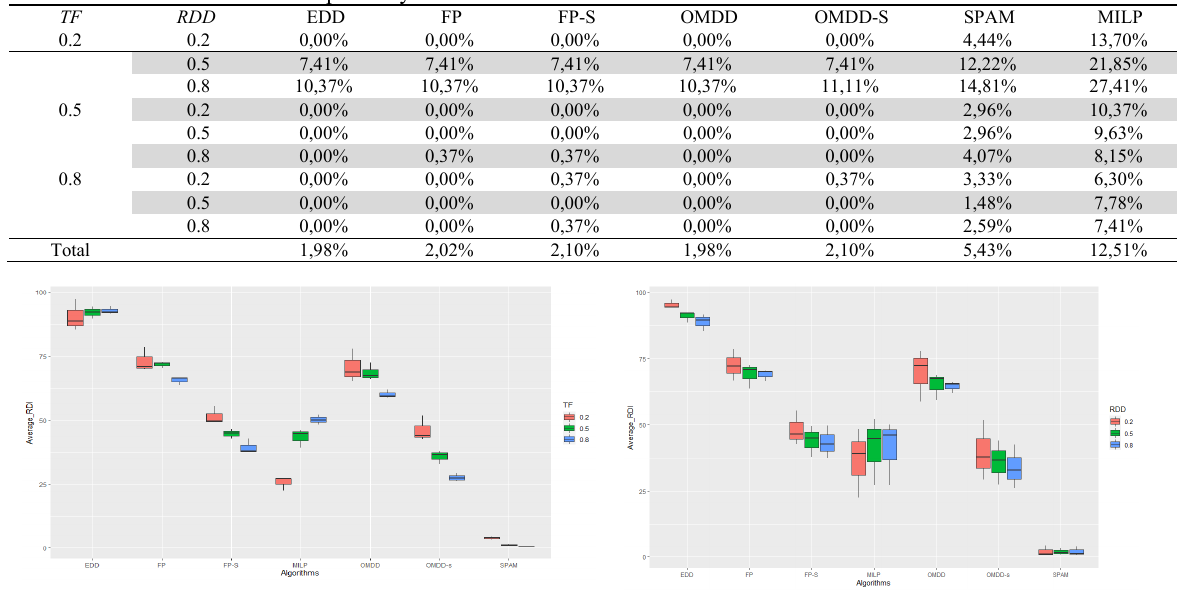
Small-sized test instances: % of optimality for TF and RDD